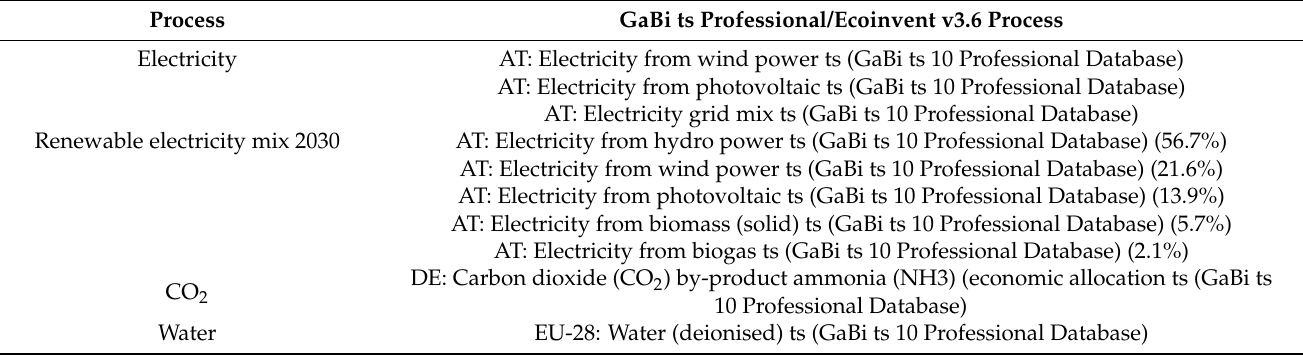
Table 4. Life cycle inventory—process and their accumulated process from the database.